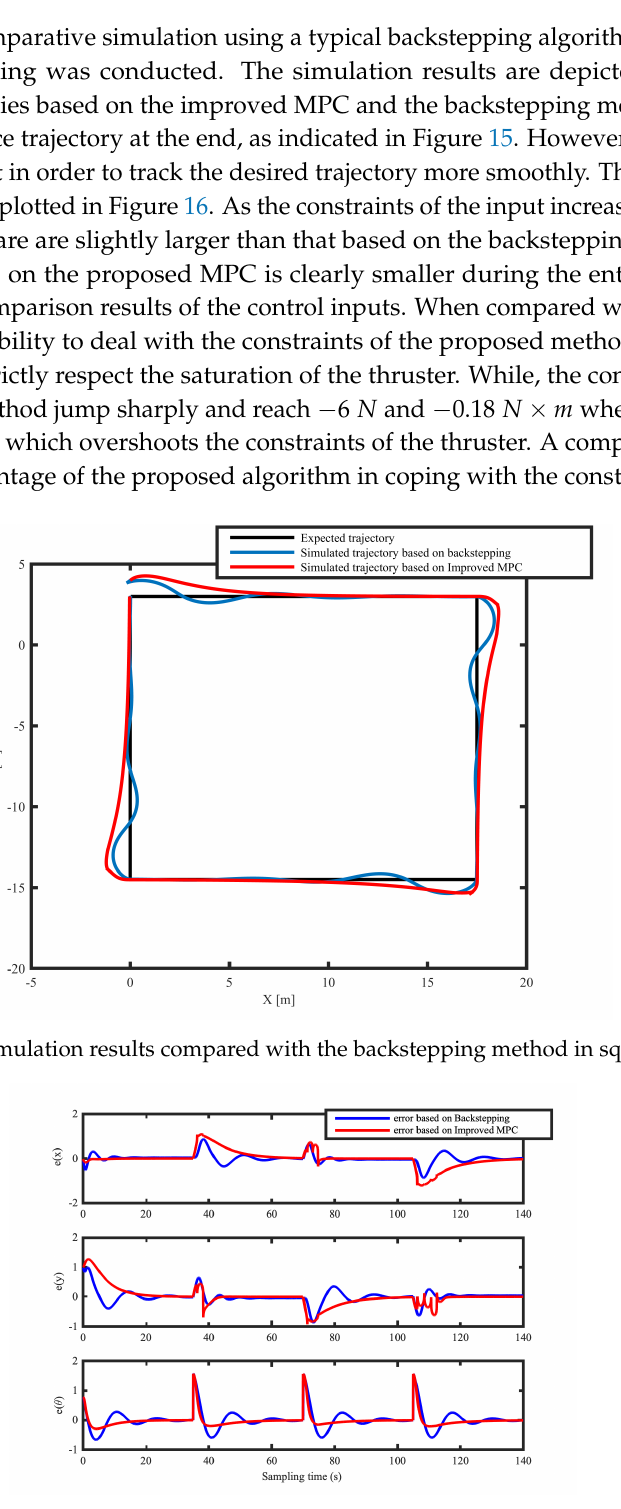
Figure 16. The comparison of the state errors with the backstepping method in square